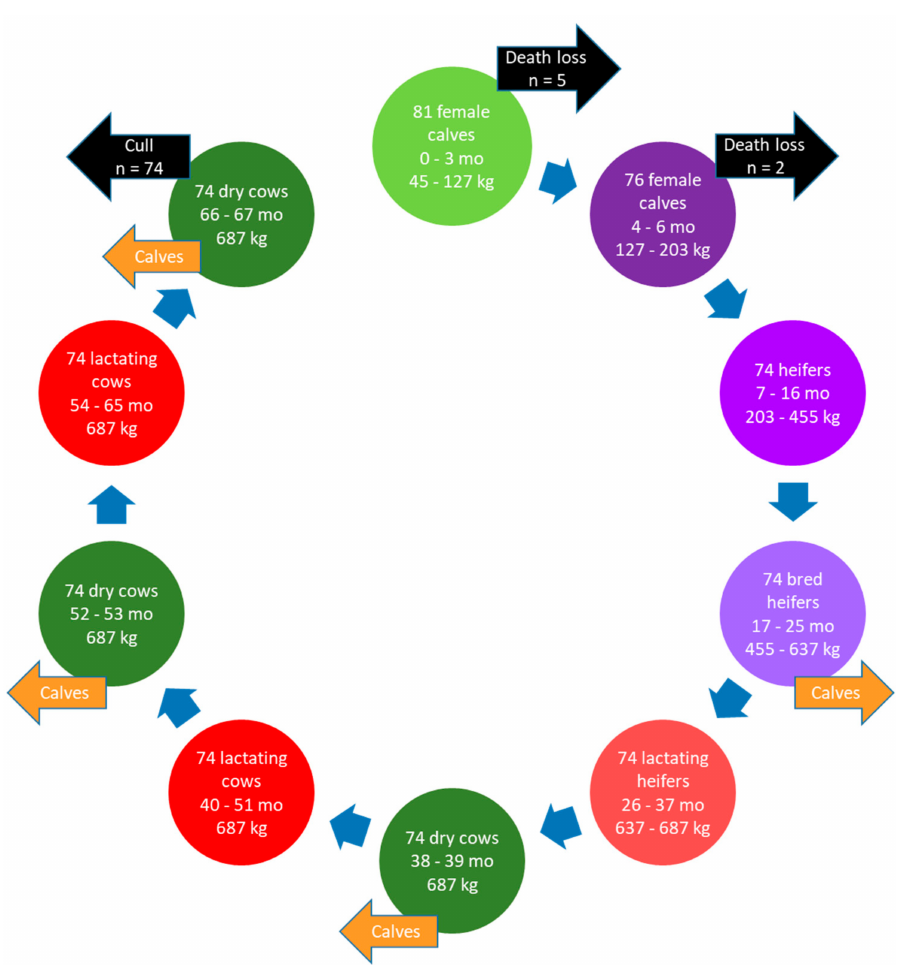
Figure 1. Life cycle of a dairy herd in Quebec illustrating the herd dynamics over time for dairy cows with a productive lifespan of three